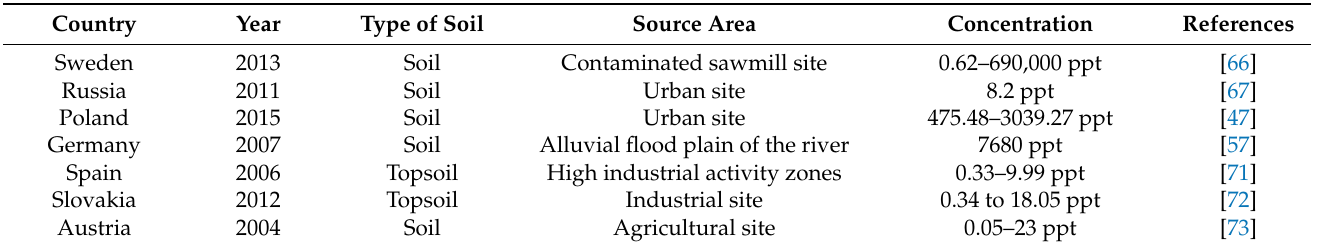
Table 2. The average concentration of dioxins (homogeneous unit calculated in ppt TEQ in dry weight) in some different nations in